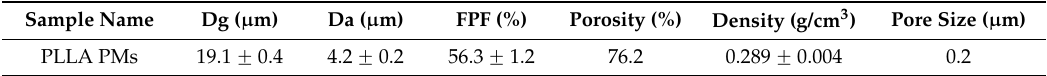
Table 2. Aerodynamic properties of the PLLA PMs.